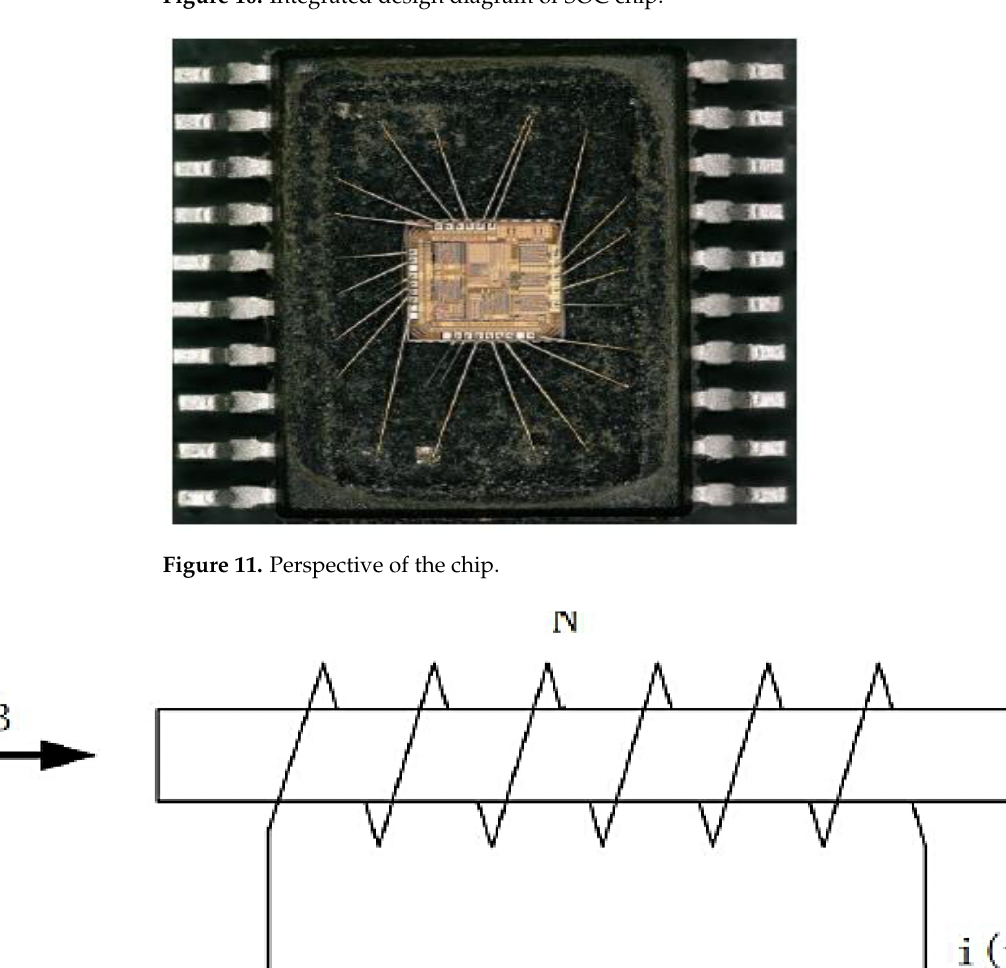
Figure 12. The structure of single-core winding fluxgate structure.